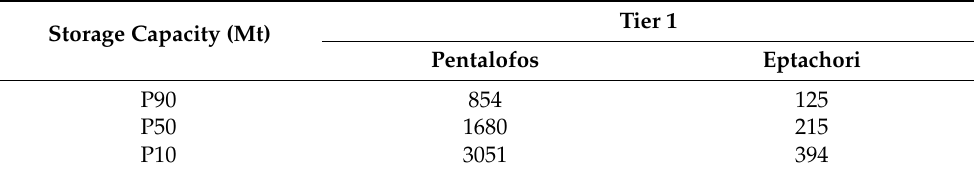
Table 9. Summary of CO 2 storage capacity for potential reservoirs in West Macedonia.